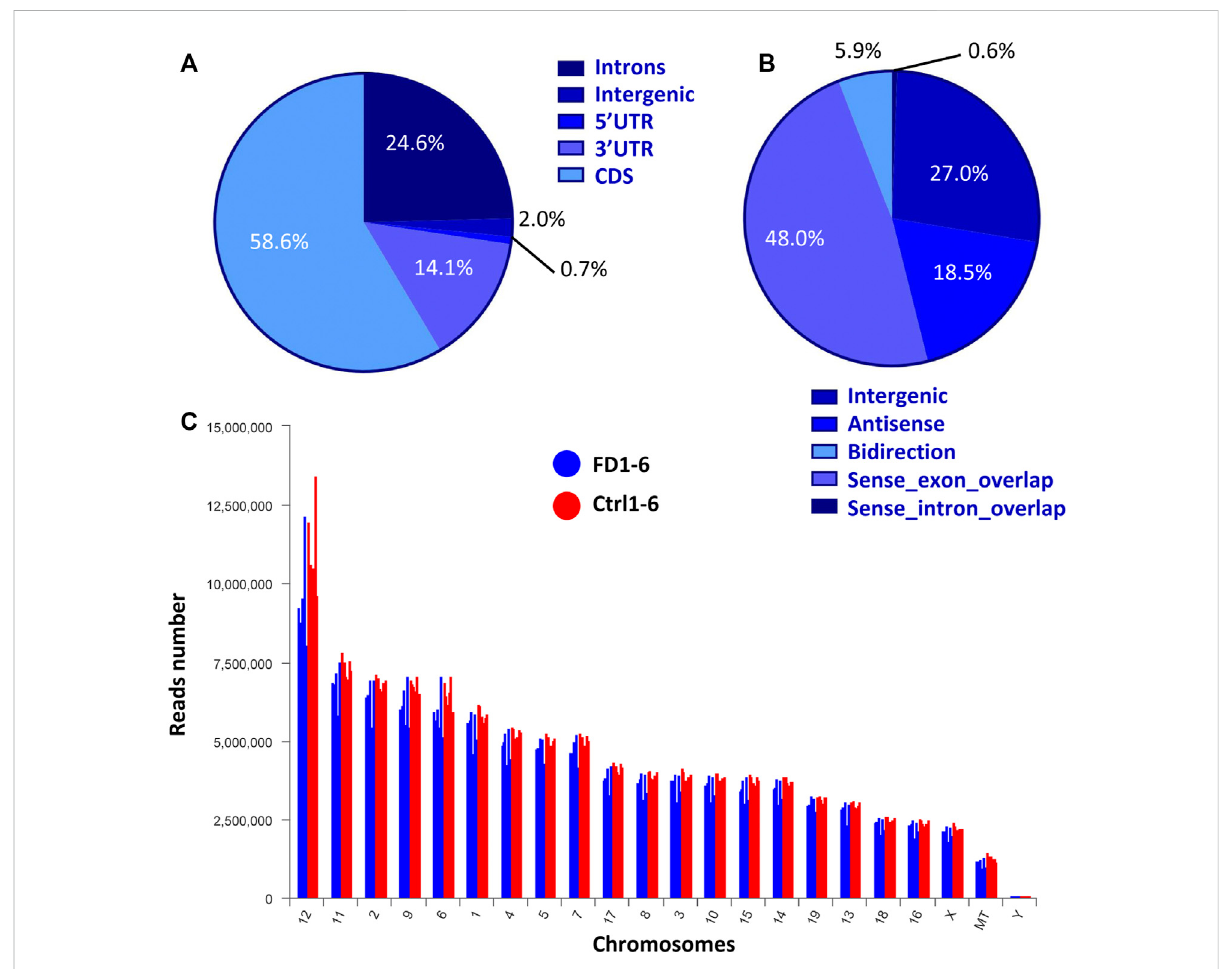
FIGURE 2 Expression characteristics of lncRNAs from both FDM and control eyes. (A) Percentages of reads mapped to genomic regions. (B) Percentages of lncRNAs classi fi ed into different groups. (C) Chromosomal distribution of lncRNA